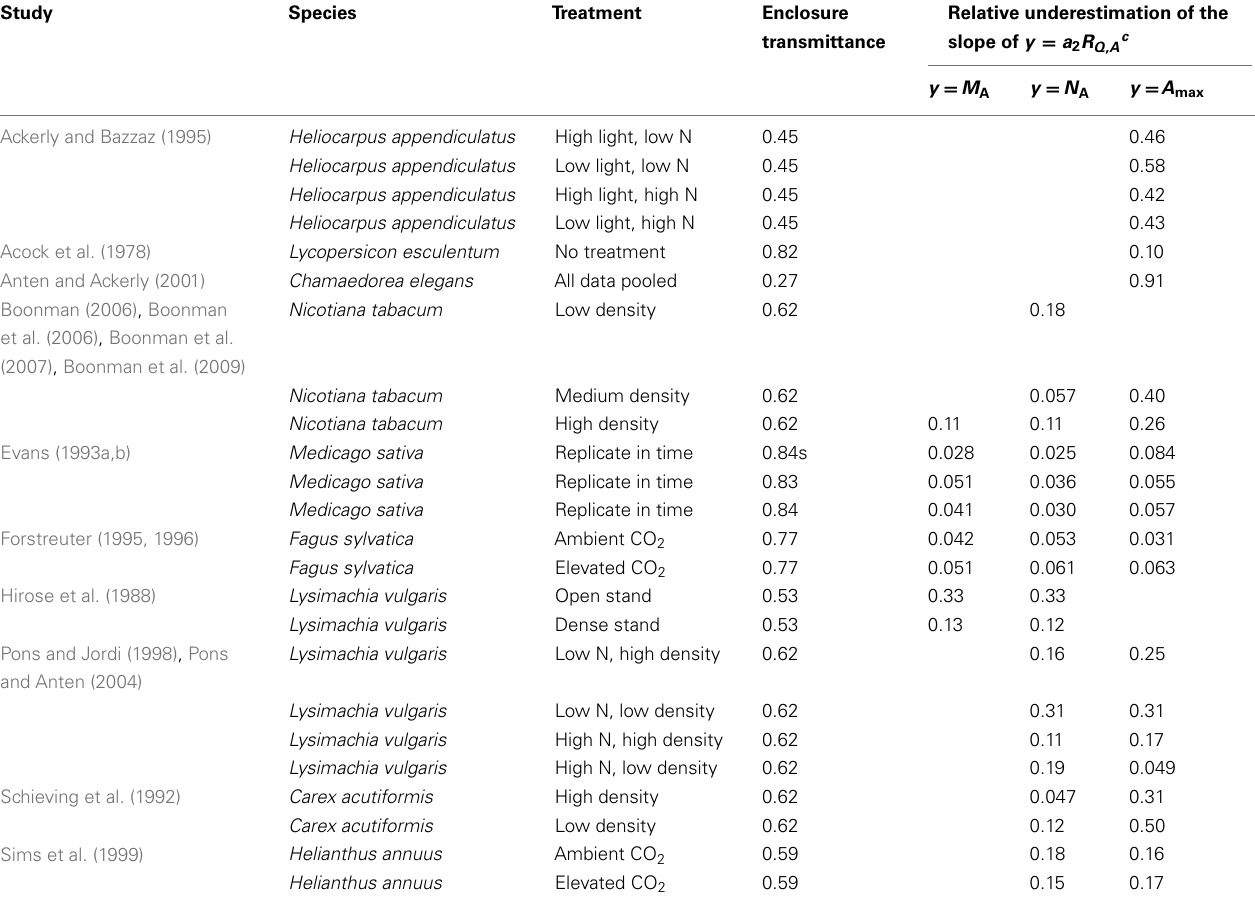
Table 3 | Enclosure transmittances and potential biases (Eq. 15) introduced in the non-linear regressions of leaf dry mass per unit area ( M A ), nitrogen content per area ( N A ), and photosynthetic capacity per area ( A max ) with apparent relative light ( R Q,A ) ∗ in studies with natural illumination in greenhouses and